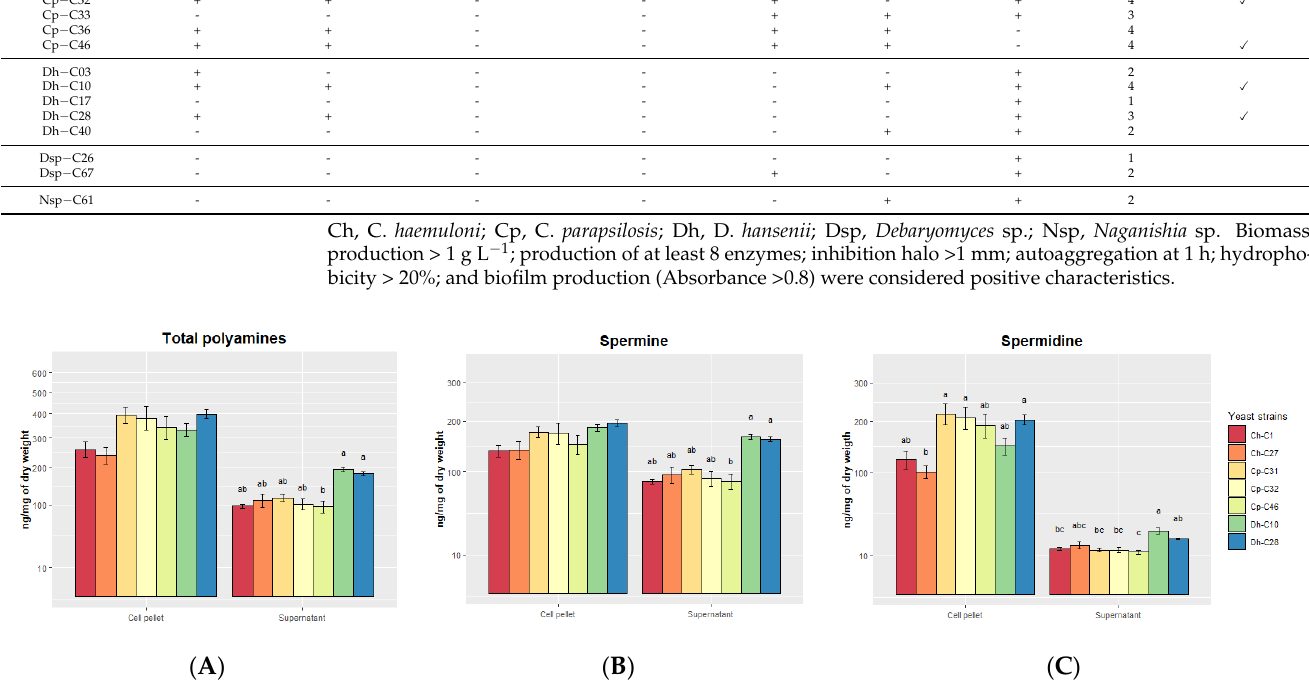
Figure 3. Polyamine production of yeast strains from the supernatants and cell pellets. ( A ) Total polyamines, ( B ) Spermine, and ( C ) Spermidine. The results are presented as the mean ± standard error. Ch, C. haemuloni ; Cp, C. parapsilosis ; Dh , D. hansenii ; Dsp, Debaryomyces sp.; Nsp, Naganishia sp. Different letters indicate significant differences ( p < 0.05) between yeast strains.